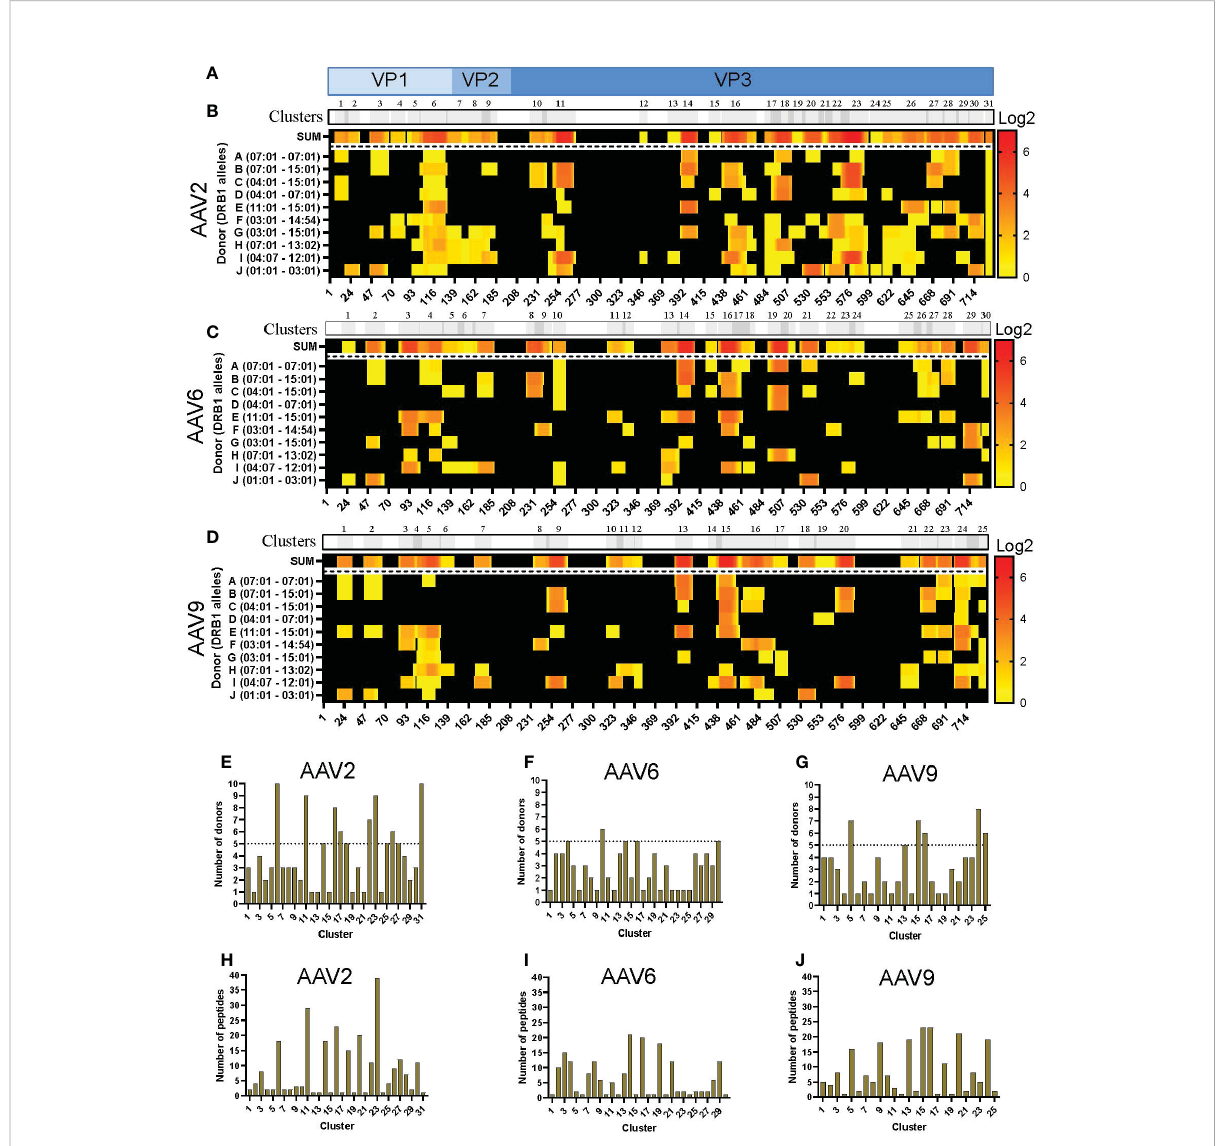
FIGURE 2 Differential levels of HLA-DR display among AAV serotypes. (A) Diagram representation of the full-length sequence of VP1, highlighting the regions that correspond to the VP1, VP2 and VP3 regions. (B-D) MAPPs peptide representation of AAV2 (B) , AAV6 (C) and AAV9 (D) . Aligned HLA-II peptides are displayed as heatmaps where: the fi rst row (in grey) represents the peptide clusters, identi fi ed by IEDB Epitope Cluster Analysis Tool 1.0. Overlapping sections of peptide clusters are shown as darker grey; the second row, shown as “ SUM, ” represents peptides summed where each amino acid is shown as the intensity relative to the number of times it was seen on the identi fi ed peptide sequences; rows 3 to 12 represent each of the donors and their DRB1 alleles. Peptide intensity in SUM and the donor rows are shown in log2 scale, where black represents no peptide presentation and red the most presentation of peptides in a particular region. At the bottom of each heatmap, the amino acid residue position is indicated. (E – G) Bar graphs showing the number of donors presenting at least one peptide from each cluster AAV2 (E) , AAV6 (F) and AAV9 (G) . The cluster numbering as in B-D is represented on the X-axis and the number of donors is shown in the Y-axis. The dotted line represents the cutoff for “ public ” clusters. (H – J) Bar graph representing the number of peptides per cluster for AAV2 (H) , AAV6 (I) and AAV9 (J) . Clusters are denoted in the text by the serotype + HLA + cluster number, e.g.